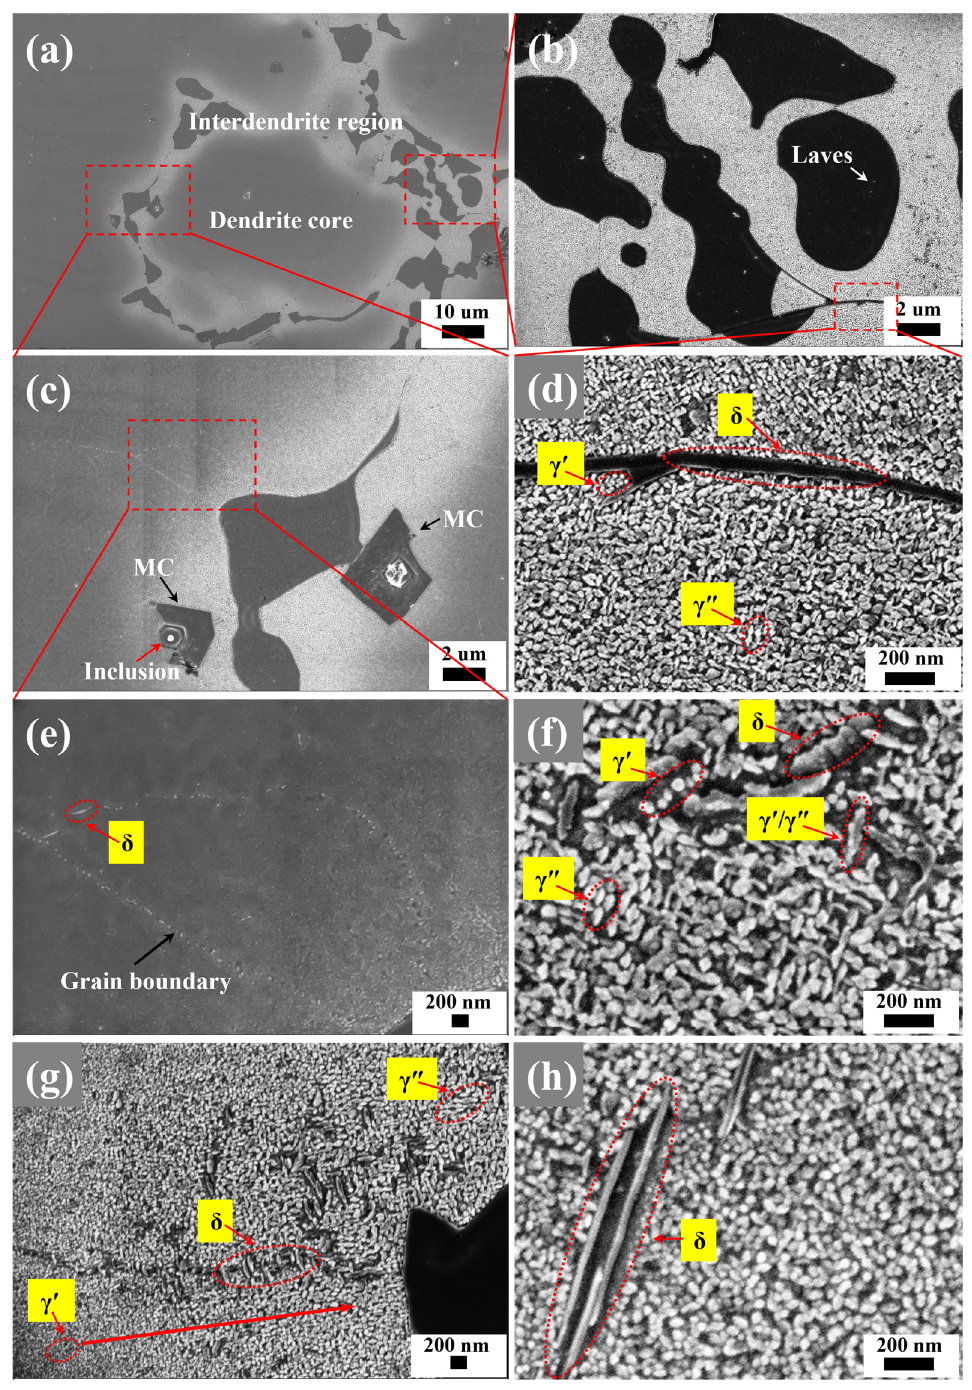
Figure 6. Morphologies of the most important precipitates of as-cast GH4169 with etchant 3 and 4 by SEM. ( a ) Microstructure of dendritic segregation. ( b ) Island-like Laves phase. ( c ) MC and Laves phases. ( d ) Long needle-like δ . ( e ) Plate-shaped δ precipitates at grain boundaries. ( f ) Finely dispersed mixture of γ″ (ellipsoidal [3,5,29,30]), γ′ (spherical [3,4,29,30]), γ′ / γ″ (co-precipitated composite [30,31]), and δ (plate-shaped [3,5,26]), precipitates. ( g ) Change trend of precipitates with Nb content increasing. ( h ) Fine needle-like δ . The phase types of the fine γ″ , γ′ , γ′ / γ″ , and δ precipitates are predicted based on their reported features in the literature [3–5,18,26,29–32]. Under higher magnification, short rod-like or plate-shaped δ precipitates can be observed in Figure 6f–h, spherical γ′ precipitates with diameters of 20 to 50 nm, usually pre-